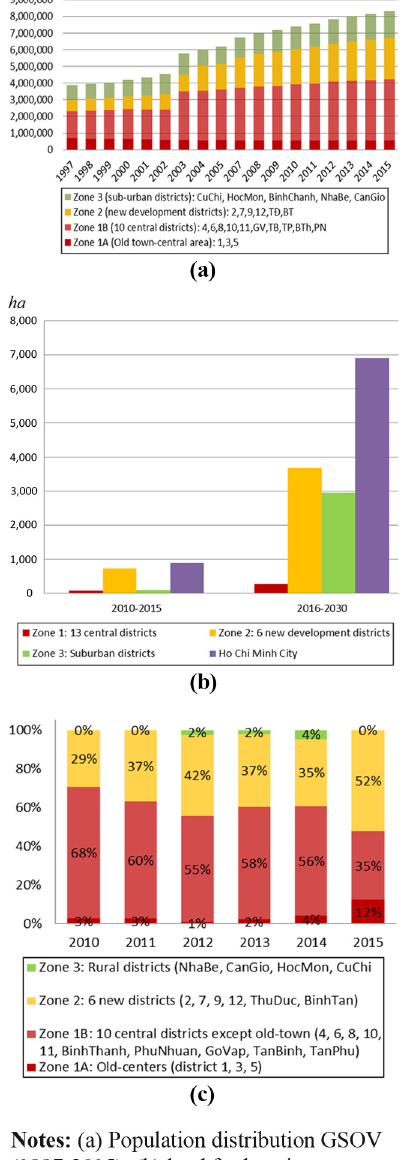
Figure 4. Urban development and fl ood